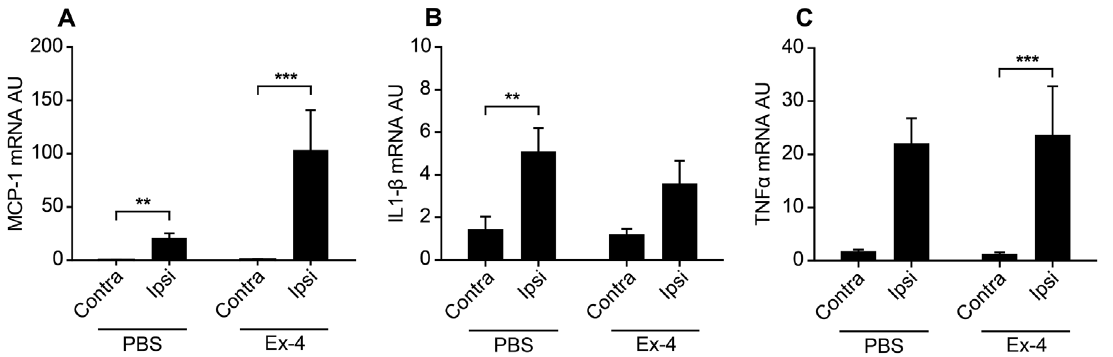
Figure 4. Stroke increase gene expression of pro-inflammatory cytokines (Study 4). Gene expression of pro-inflammatory cytokines MCP-1 (A), IL-1 b (B) and TNF a (C) was analyzed by real-time PCR in brain homogenate from mice 3 days after MCAO. Gene expression was normalized to YWHAZ and expressed as arbitrary units (AU). Data are presented as means 6 SEM. ** and *** denote p , 0.01 and p , 0.001 respectively.